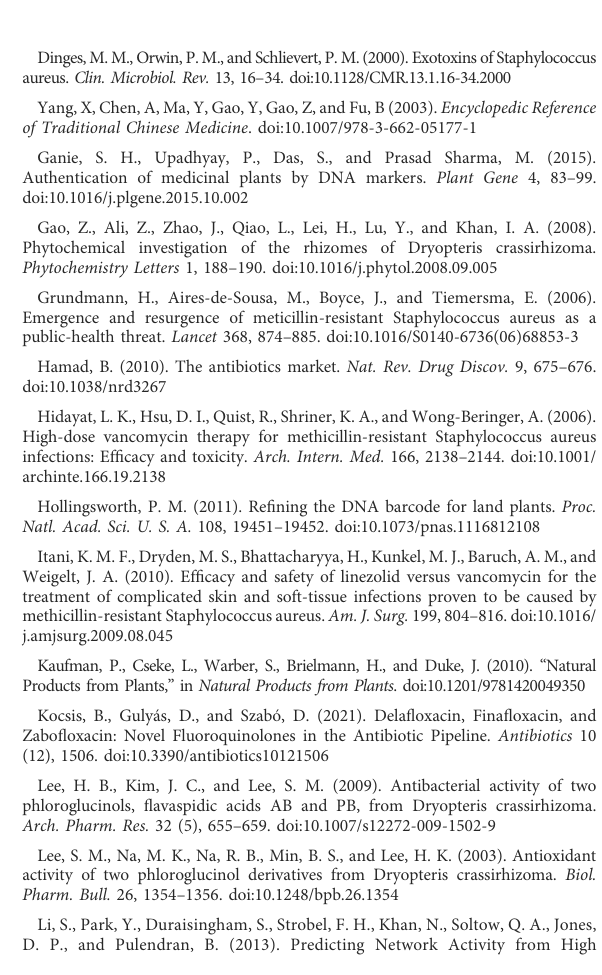
SUPPLEMENTARY TABLE S1 m/z matrix derived following fl ow-infusion electrospray mass spectrometry.